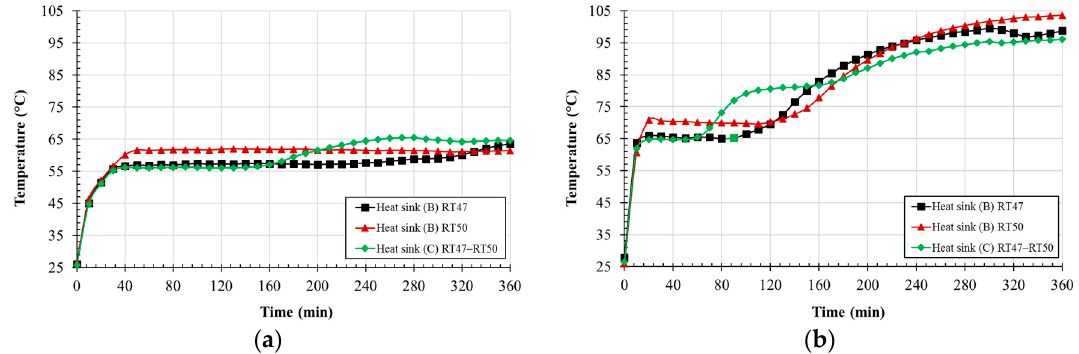
Figure 13. Heat sink surface temperature of one and two PCM heat sinks at power rating, ( a ) 1.0 W and ( b ) 2.0 W.